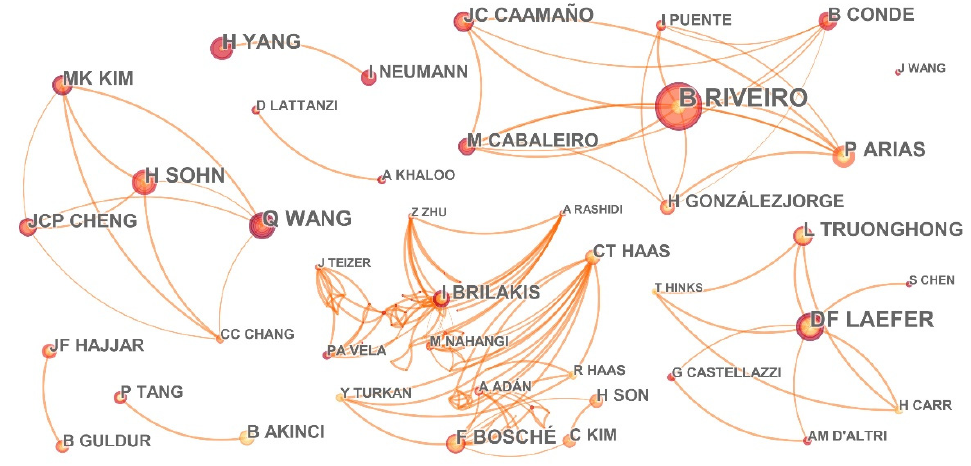
Figure 4. Network of co-authorship. Table 3. General features of the co-authorship network.